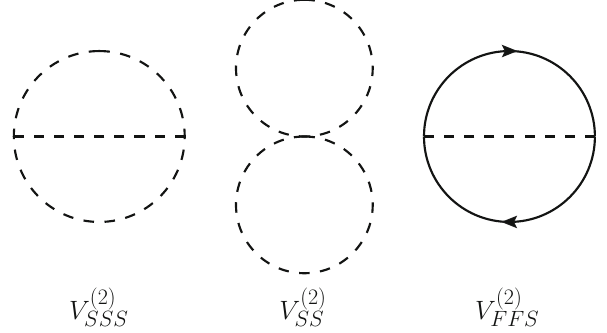
Fig. 2 Topologies of diagrams contributing to dominant two-loop BSM corrections to the effective potential and Landau gauge, can be taken from Ref. [121] (results